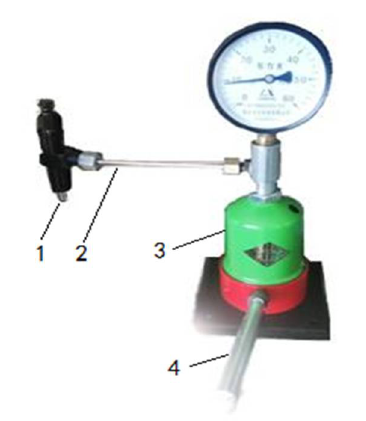
Figure 1. The high-pressure spraying device: 1—sprayer; 2—tubing, 3—hand pump; 4—compressive bar.